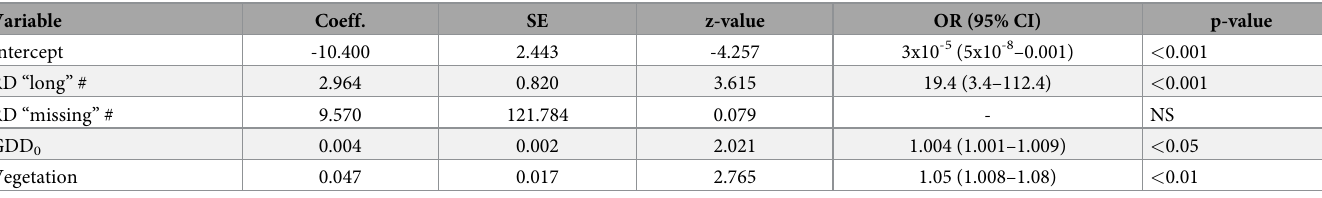
Table 6. Results of binomial regression of autochthonous arboviral case emergence for model Sc1.1.